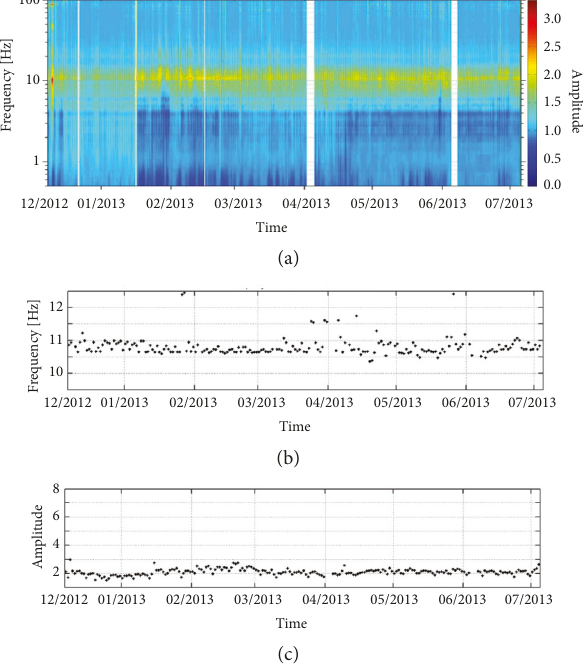
Figure 4: (a) The TOR1 HVSR amplitude, (b) the peak frequency distribution, and (c) the peak amplitude distribution over the whole monitoring period.